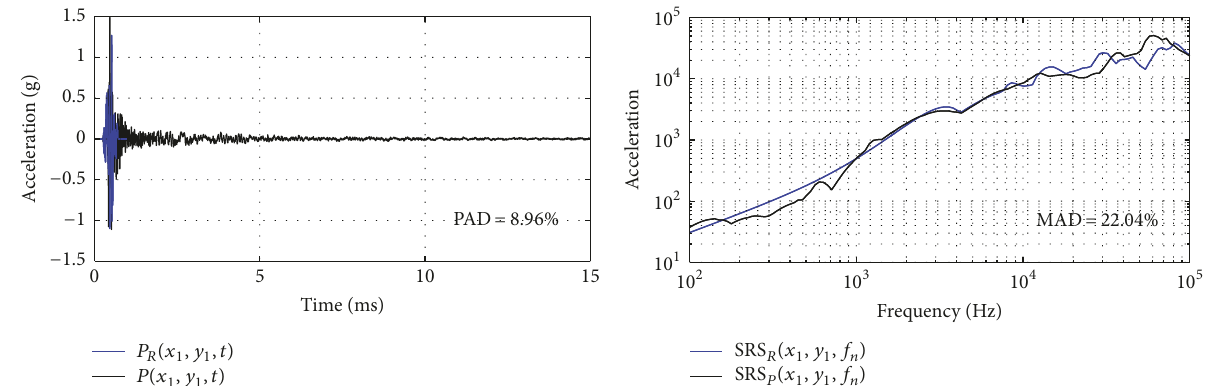
Figure 13: Time domain signal reconstruction at point 1, training